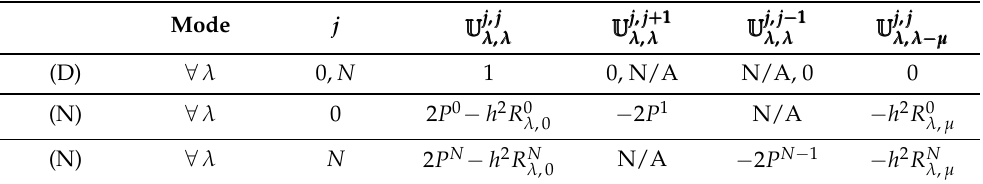
Table 3. Non-vanishing matrix elements of matrix U that define DBC (D) and NBC (N) for an annulus. N/A specifies those elements that lay outside U .